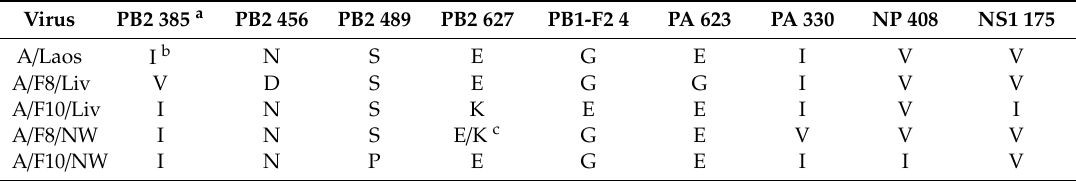
Table 5. Amino acid sequence changes in ferret-passaged A / Laos virus egg-amplified stocks.